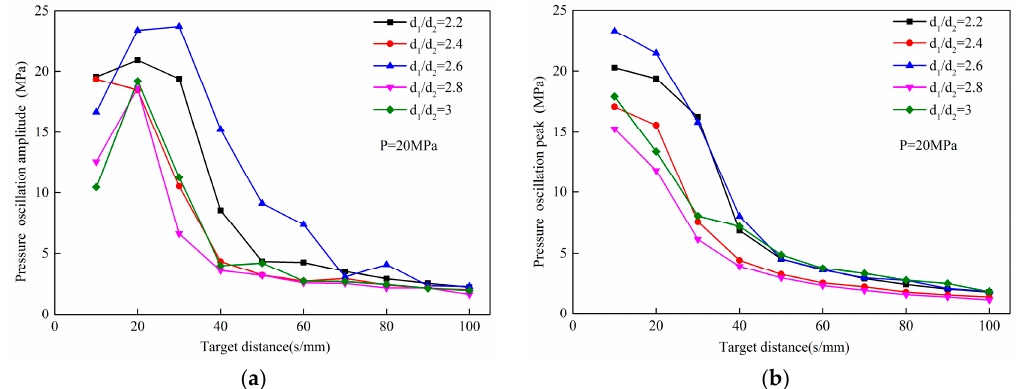
Figure 8. Effect of d 1 / d 2 on nozzle performance at 20 MPa pressure. ( a ). c urves of nozzles with different Figure 8. E ff ect of d 1 / d 2 on nozzle performance at 20 MPa pressure. ( a ). curves of nozzles with di ff erent d 1 / d 2 on pressure pulsation amplitude at different target distances. ( b ). c urves of nozzles with different d 1 / d 2 on pressure pulsation amplitude at di ff erent target distances. ( b ). curves of nozzles with di ff erent d 1 /d 2 on pressure oscillation peak at different target distances. d 1 / d 2 on pressure oscillation peak at di ff erent target